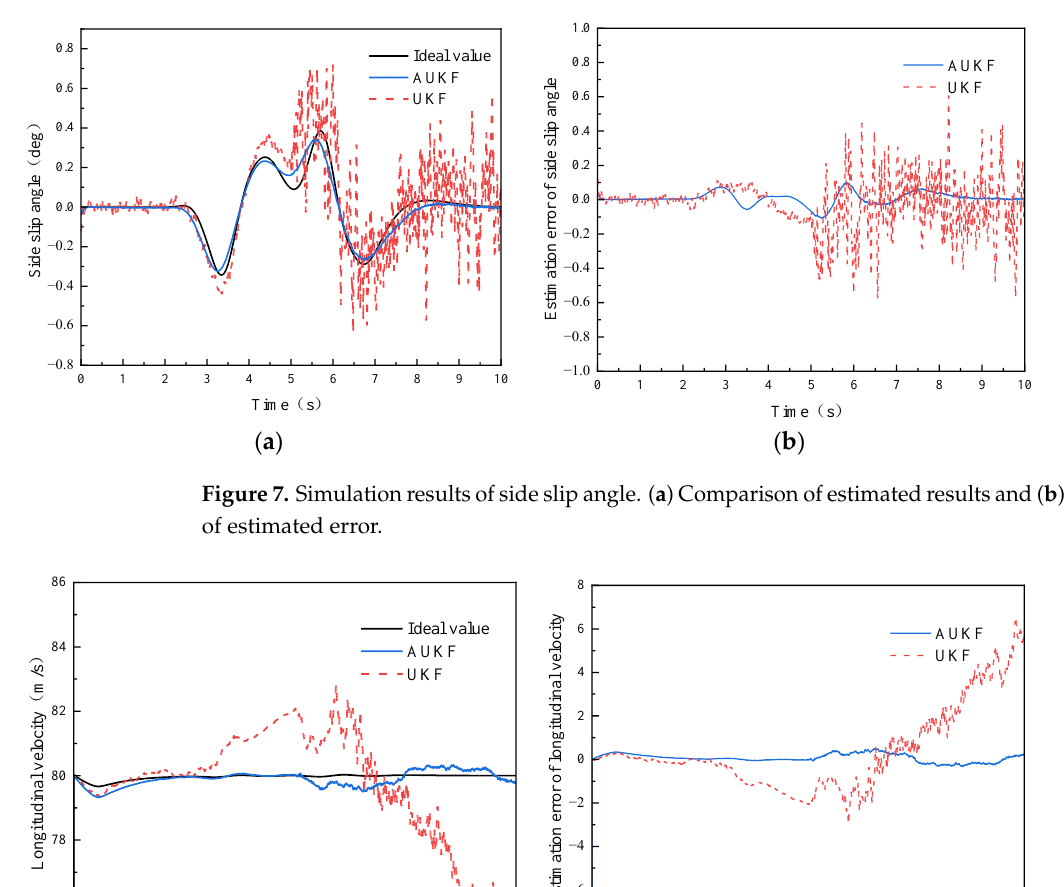
Figure 6. Simulation results of yaw rate. ( a ) Comparison of estimated results and ( b ) comparison of estimated error.